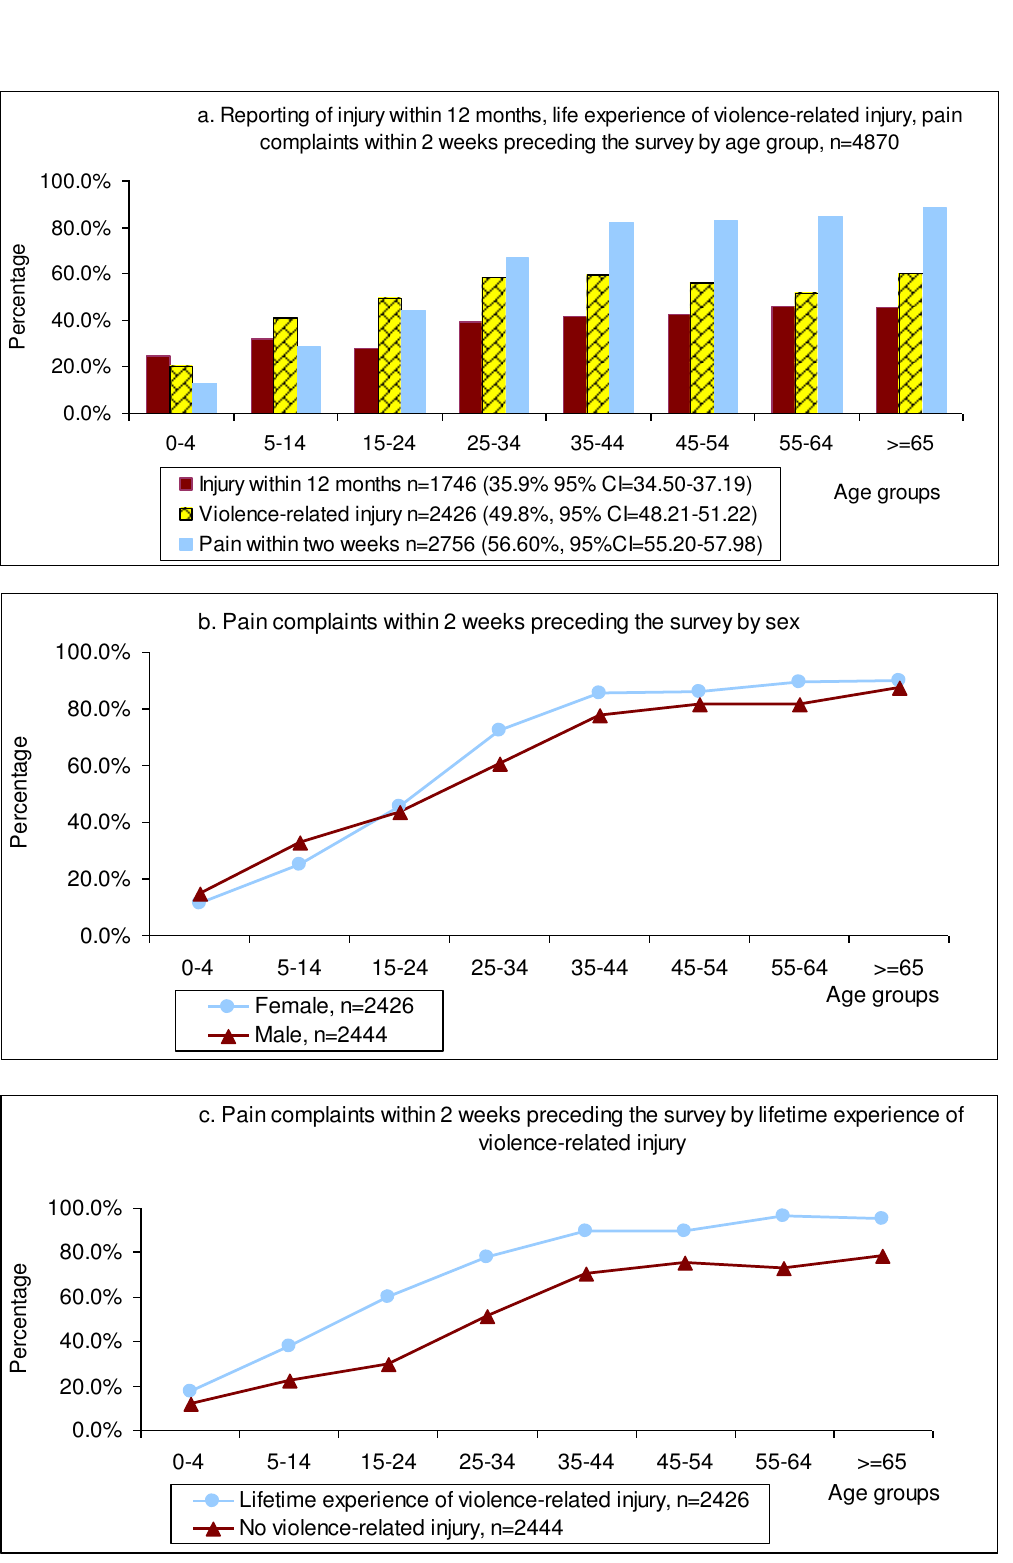
Figure 3 Prevalence of injury, lifetime experience of violence-related injury and pain complaints by age groups